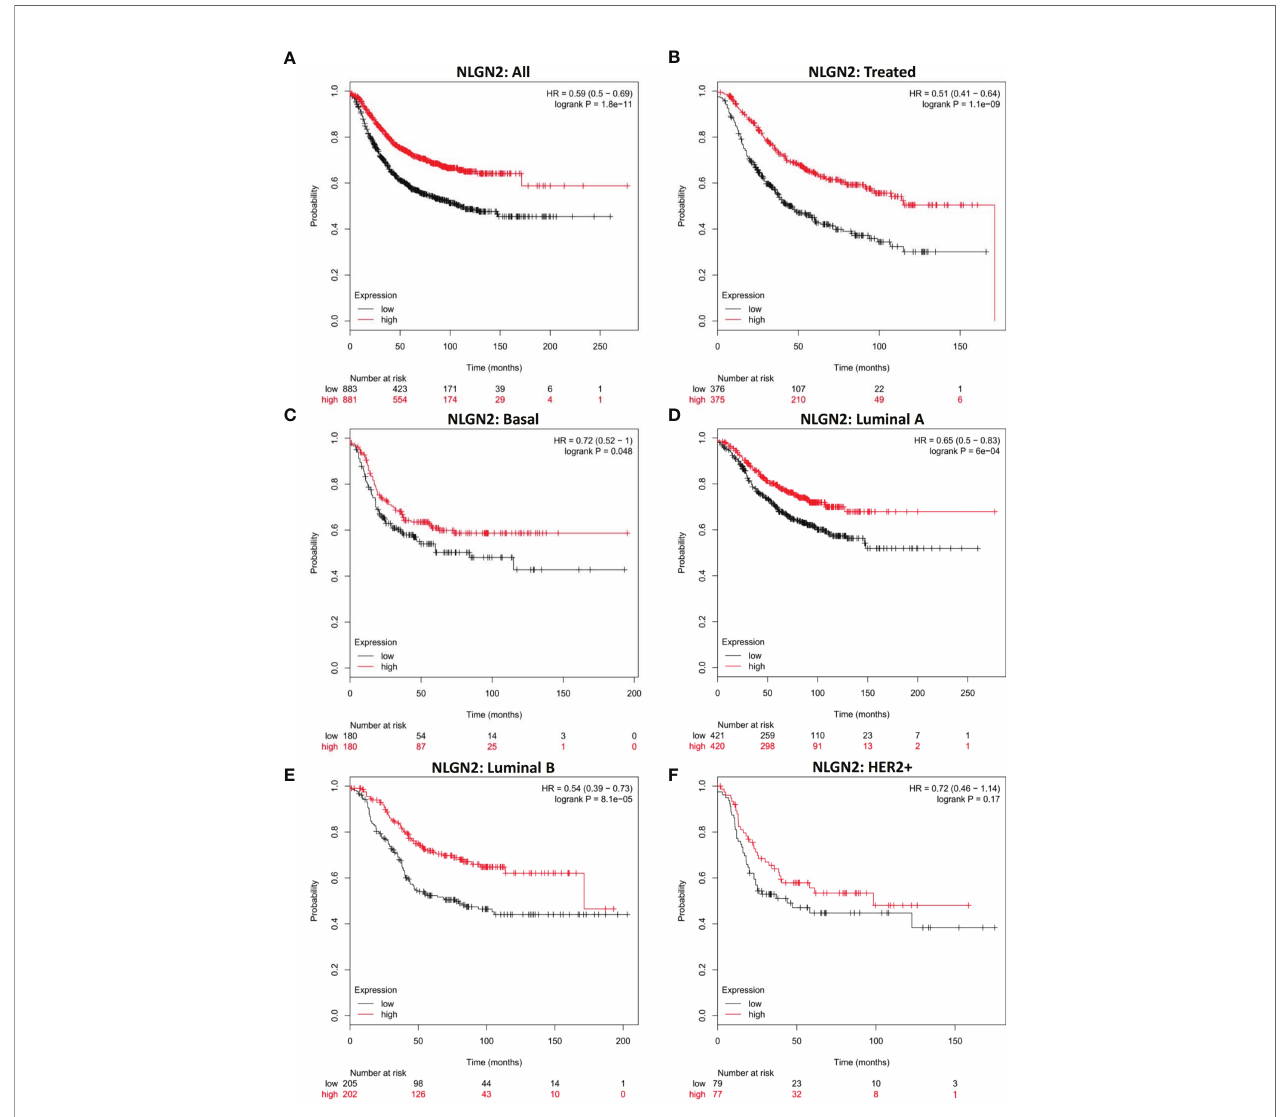
FIGURE 1 | NLGN2 is a prognostic factor of breast cancer. (A) Prognostic analysis of NLGN2 in breast cancer. (B) Prognostic analysis of NLGN2 in post-treated breast cancer. (C) Prognostic analysis of NLGN2 in basal breast cancer. (D) Prognostic analysis of NLGN2 in luminal A breast cancer. (E) Prognostic analysis of NLGN2 in luminal B breast cancer. (F) Prognostic analysis of NLGN2 in HER2+ breast cancer. The HR and log rank p values are indicated in each panel, and p < 0.05 is statistically signi fi